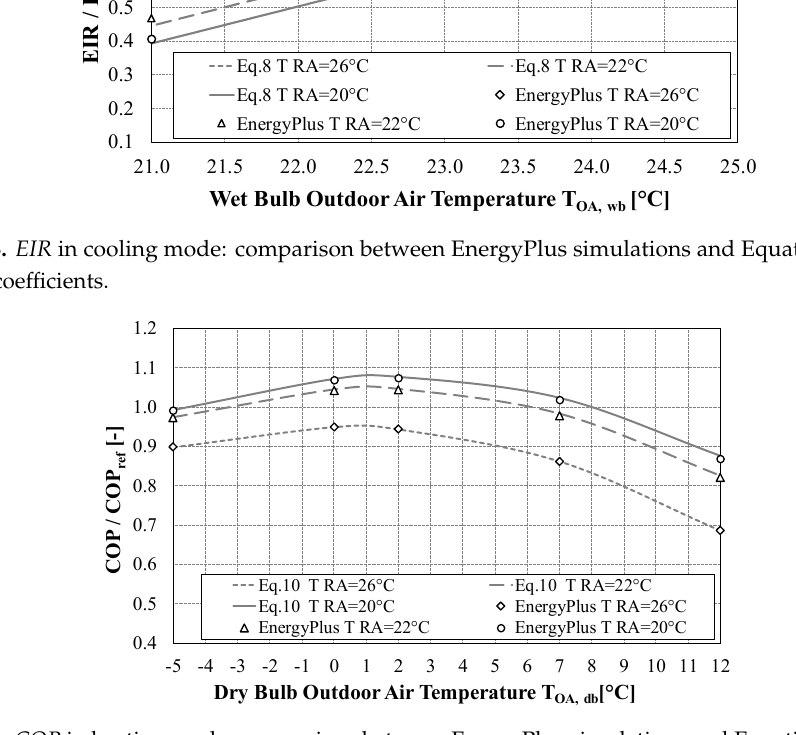
Figure 9. COP in heating mode: comparison between EnergyPlus simulations and Equation (10) with Table 6 coefficients.